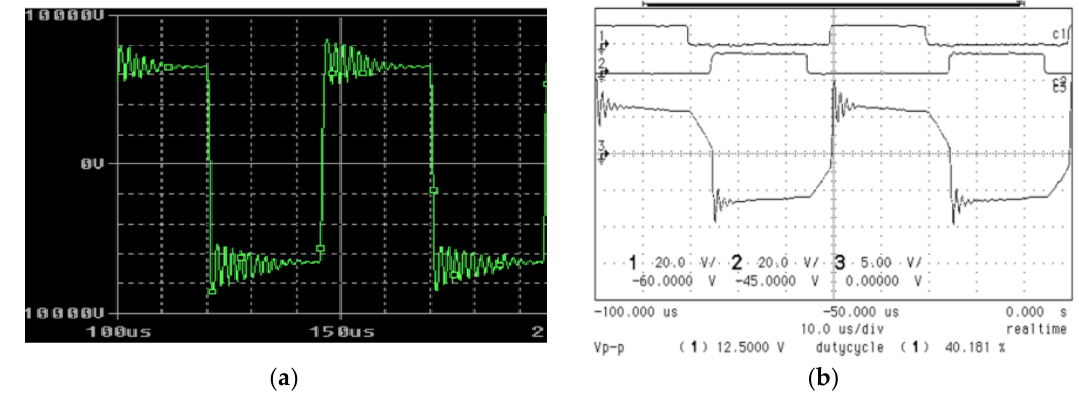
Figure 19. ( a ) Output voltage waveform obtained in a PSPICE environment simulation, ( b ) same voltage waveform (signal 3) measured in 1 turn of the secondary side of the HV transformer.